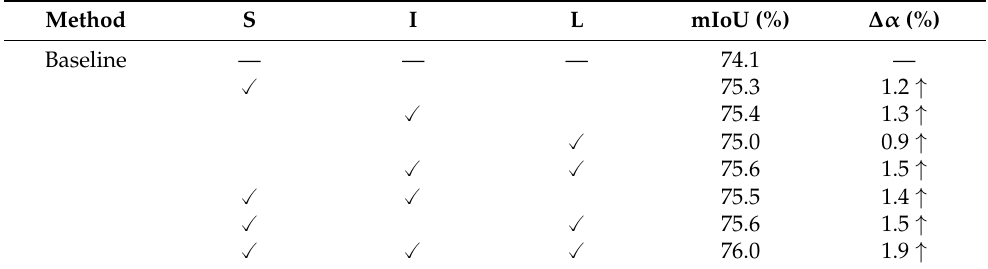
Figure 7. Visualization of features. Our module enhances the representation of more structural features. Table 2. Ablation studies of different level context on Potsdam test